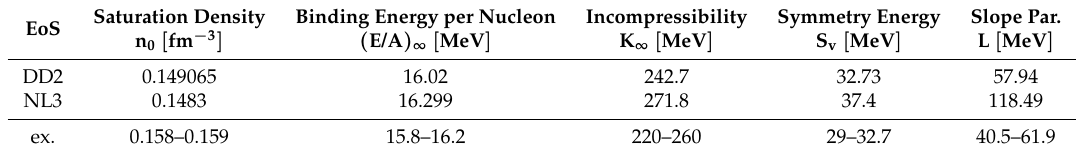
Table 1. Selected properties of the hadronic equations of state (T = 0, µ C = 0) and their experimental constraints (cf. [34–36]).